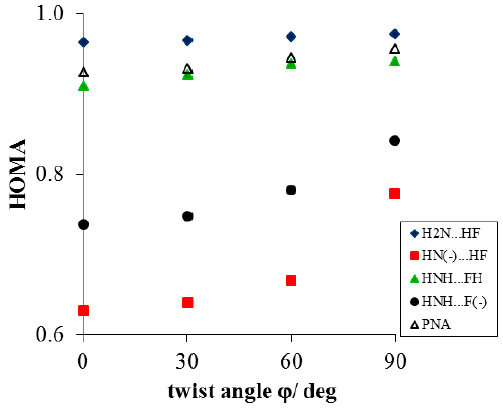
Figure 13. Dependences of HOMA values on rotation angle φ of NO 2 group (for equilibrium structures, except for HNH···F − interactions).